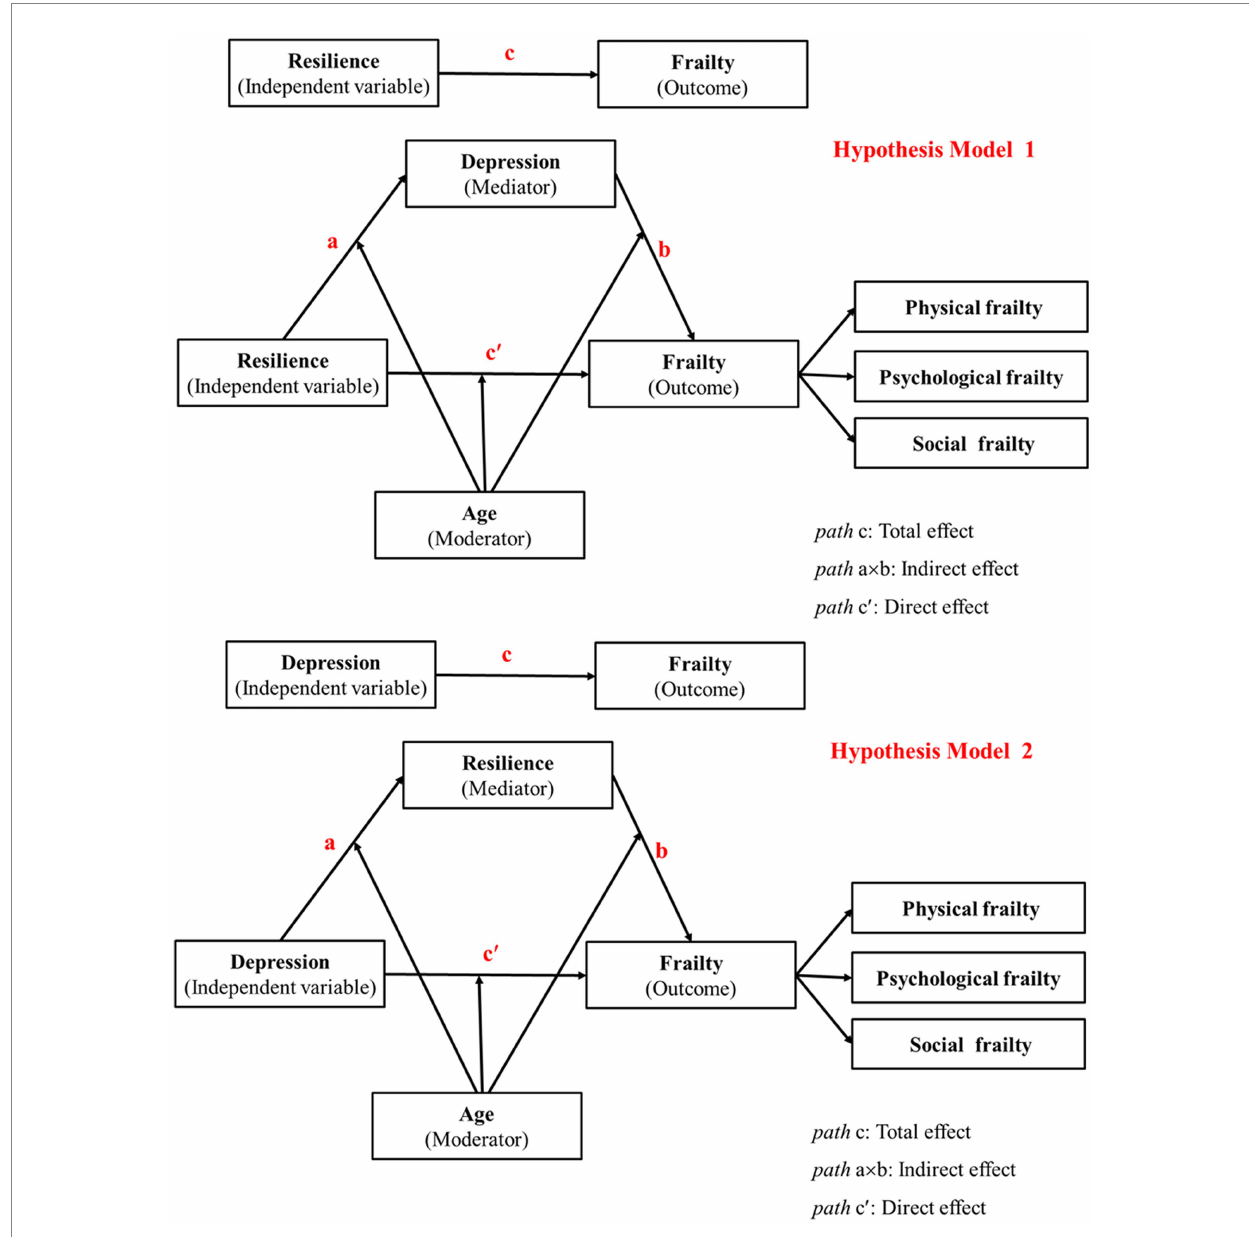
FIGURE 1 Hypothesis models of age as a moderator of the relationship between resilience, depression and